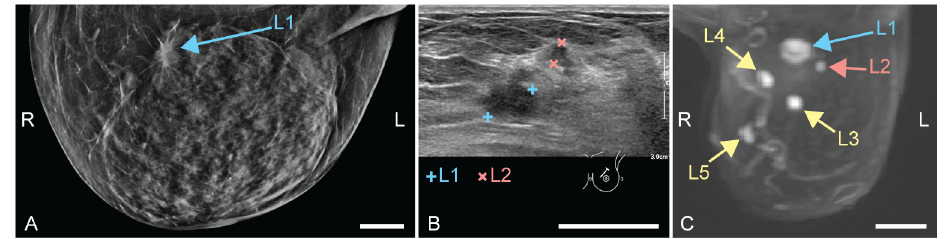
Fig 3. Case 1: Diagnostic images of a multifocal carcinoma in the left breast. L and R indicate left and right, respectively. (A) Craniocaudal x-ray (CC-MMG), with the suspect mass indicated by L1. (B) Ultrasound (US) image, where the main lesion is indicated with blue and a satellite lesion with pink. (C) Perfusion maximum intensity projection magnetic resonance (MR) image. The initially detected mass is indicated by L1. The satellite lesion as detected by US is L2. Three more foci were found though MR investigation: L3, L4 and L5. All scale bars represent 20